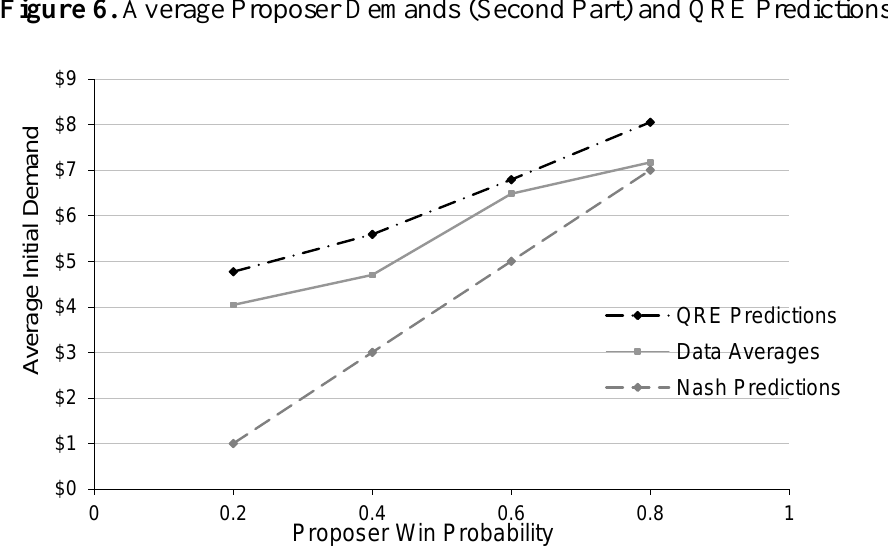
Figure 6. Average Proposer Demands (Second Part) and QRE